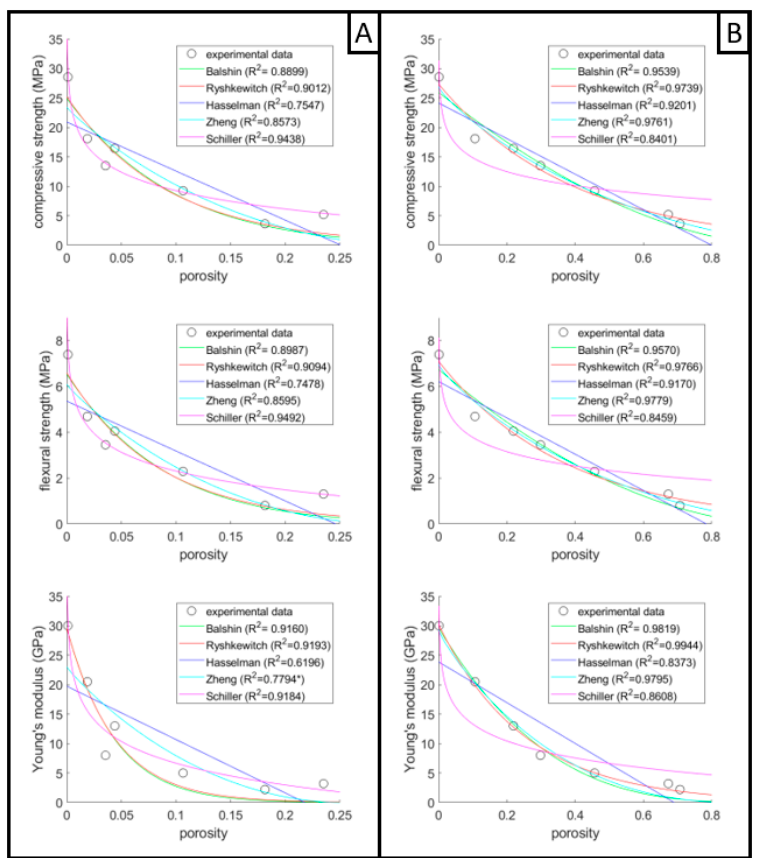
Figure 3. Correlation between compressive strength, flexural strength, Young’s modulus and porosity of the pristine mortar and mortar containing 15, 30, 45, 60, 75, and 90% vol of waste plastic. ( A ) the porosity is only the extra-porosity ( B ) the porosity is the extra-porosity plus the plastic aggregate. In the case where only the extra-porosity with respect to the reference sample is con- sidered, the best model seems to be the Schiller model. On the contrary, when the plastic waste is counted as porosity, the best fit is obtained with the Ryshkewitch or the Zheng model for strength and Ryshkewitch model for Young’s modulus. The Schiller model is known to be less effective for porosity values close to 0% and 100%; in this case, it is clear that when the porosity range is very wide, this model is less effective, while it works much better on a narrow porosity range; also in this case, however, the divergence for zero po- rosity is an issue to be considered when applying this model. An additional set of calculations was carried out considering only a fraction, f, of the plastic acting as pores. In this case, the effective porosity was an intermediate value be- tween the extra-porosity with respect to the reference sample and the sum of extra-poros- ity and plastic content. The calculation showed that the best R 2 fit is obtained again with Zheng and Ryshkewitch models, and in particular for the case in which all the plastic aggregate is considered as porosity. Since the Zheng model approach is to consider the pores as a second phase with zero modulus, the improved accord between model and experimental data when all the plastic